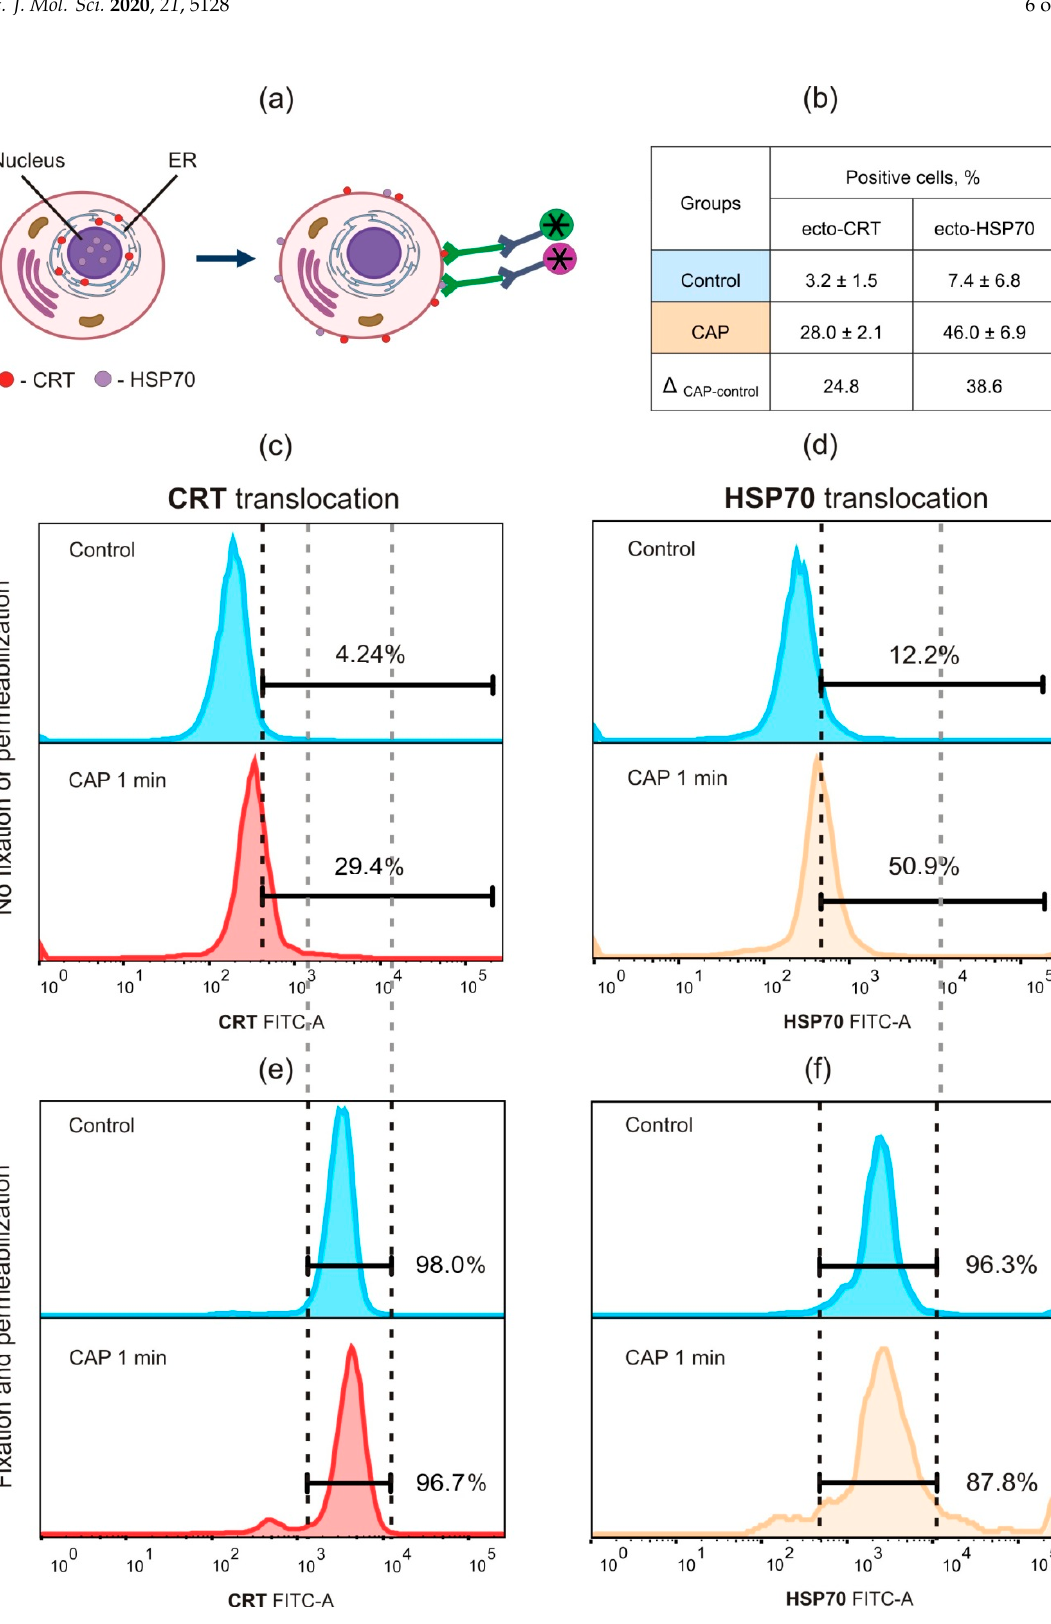
Figure 4. CAP-dependent translocation of CRT and HSP70. ( a ) The scheme of the analysis of CRT and HSP − 70 translocation to the outer cellular membrane. MX − 7 cells were irradiated by CAP for 1 min and 24 h after ecto-CRT and ecto-HSP70 were analyzed. ( b ) Quantification data for the ecto-CRT and ecto-HSP70 positive cells. ( c – f ) Analysis of the extracellular ( c , d ) and total ( e , f ) CRT and HSP70. MX − 7 cells were stained with anti-CRT ( c , e ) and anti-HMGB1 ( d , f ). Staining was performed with ( e , f ) or no ( c , d ) fixation and permeabilization. Representative graphs of three independent repeats.